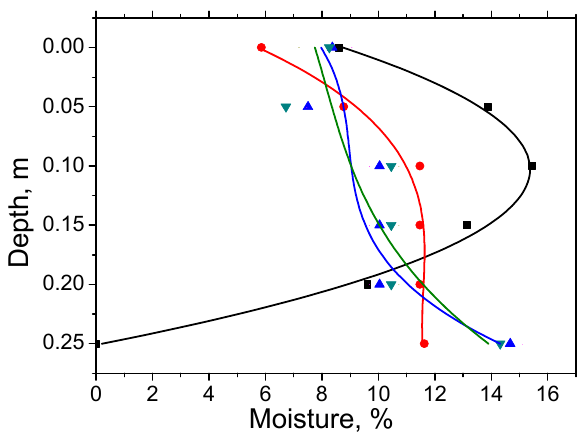
Figure 15. Directly measured moisture contents as functions of depth, and their approximation by polynomials of the third degree. To indicate the time, symbols and colors are used: immediately after soaking— ■ (black); after 1 day— ● (red); after 2 days— ▲ (blue); after 3 days— ▼ (green).